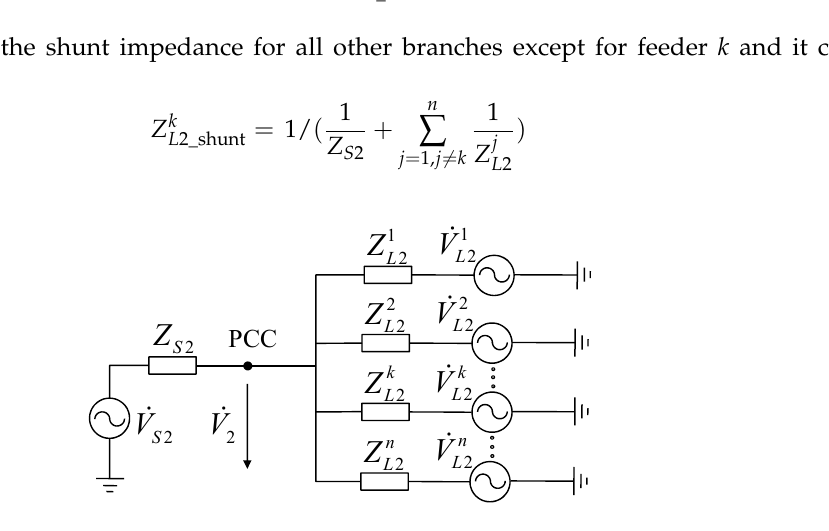
Figure 2. Analysis circuit for concentrated-multiple unbalanced source system.